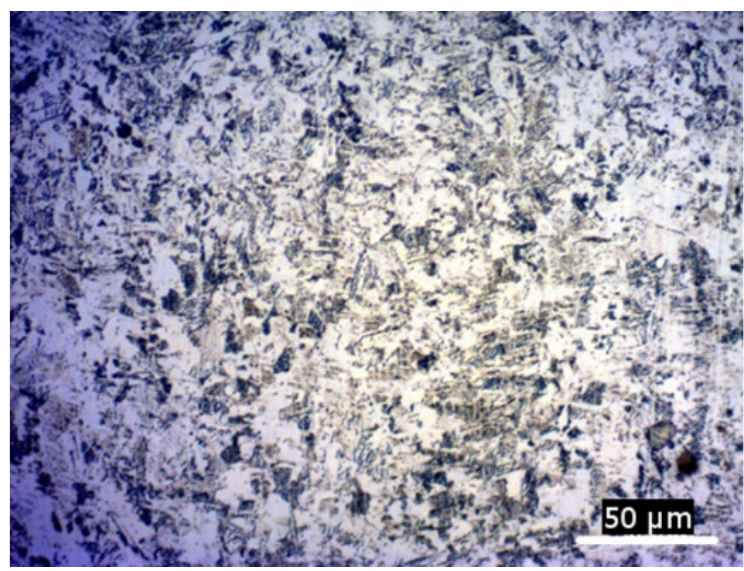
Figure 14. Duplex microstructure produced with the modified scan strategy.